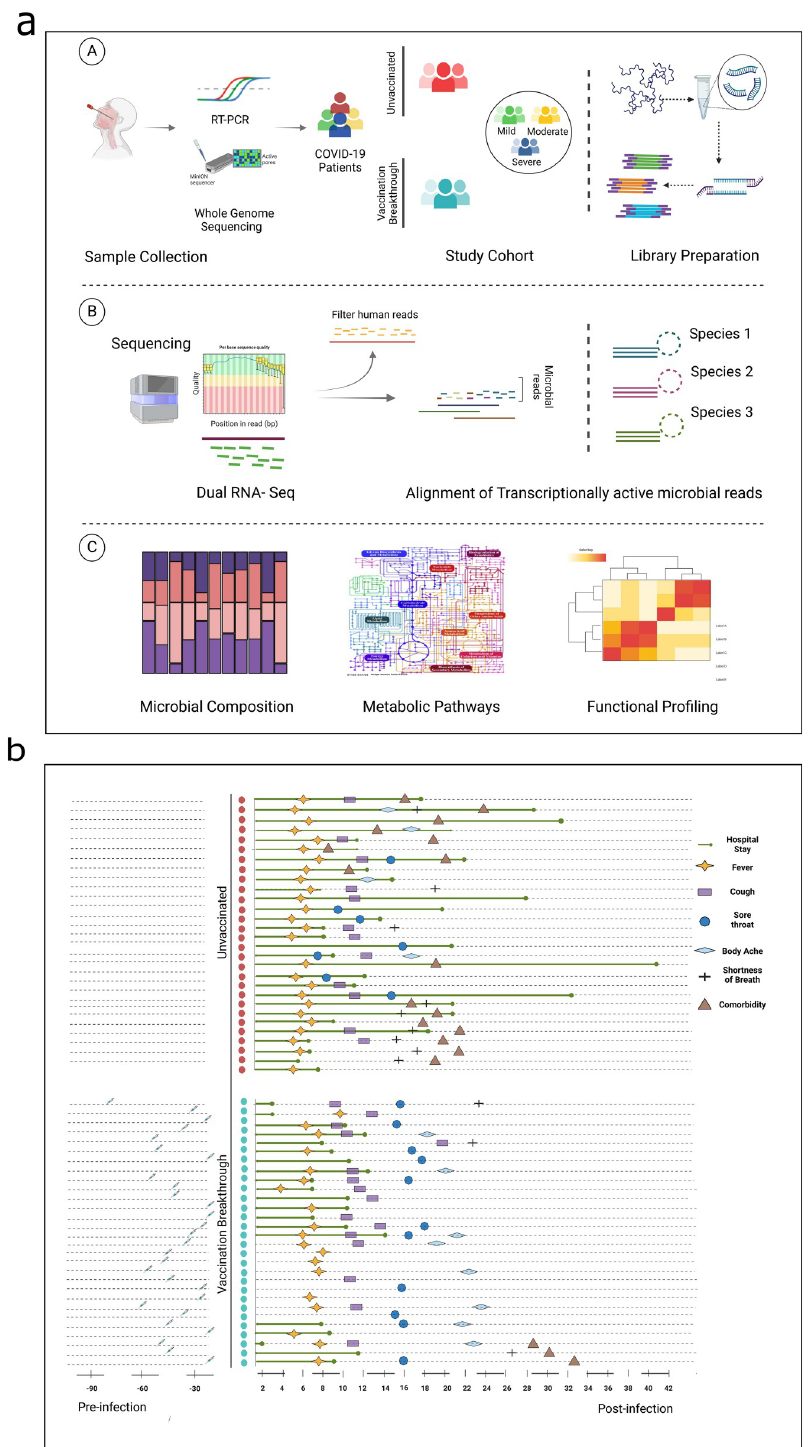
Fig 1. Summary of study cohort, dual RNA-seq, functional analysis, inference and clinical sample metadata. (a) Study design illustrating the patient cohorts, experimental workflow and functional interpretation of the analysis for the differentially abundant microbes. It also highlights the sample cohort of vaccination breakthrough/unvaccinated and the differential disease severity of mild, moderate and severe. (b) Individual plotting of clinical symptoms for unvaccinated and vaccination breakthrough patients with specific details of hospital stay, fever, cough, body ache, shortness of breath, comorbidities and vaccination status. Figure created with Biorender.com.